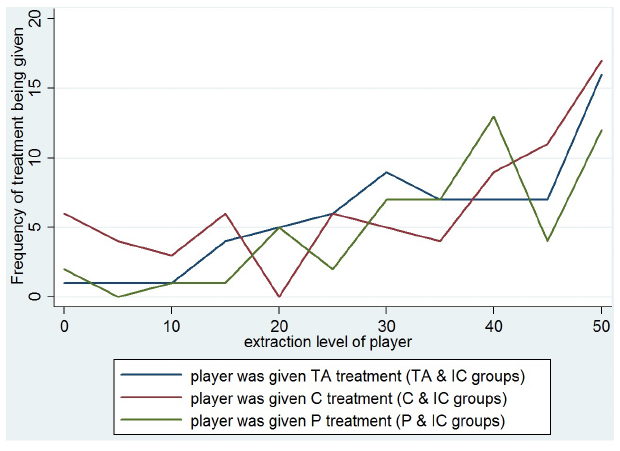
Fig. 6. Frequency of different sanction treatments applied against a player and the extraction levels of the targeted players.